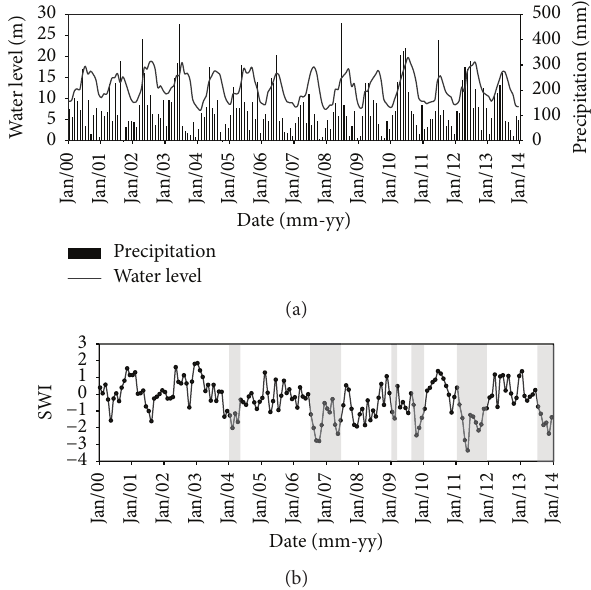
Figure3:Monthlytimeseriesof(a)thewaterlevelandprecipitation and (b) the standardized water level index (SWI). The gray areas indicatenegative SWI values duringtypical droughtyears (i.e.,